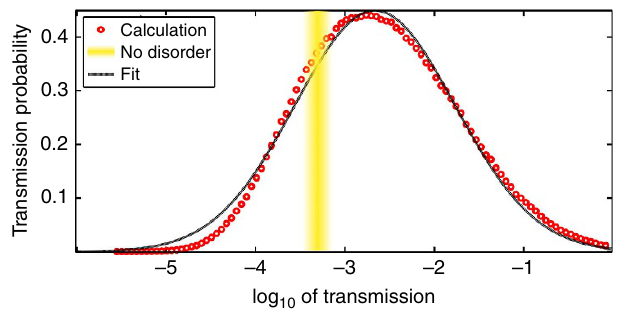
Figure 3 | Probability density of transmission in the EME regime. Transmission probability density for an N ¼ 180 structure (red circles), generated from an ensemble of 1 million realizations of the disorder. The distribution is compared against a Gaussian fit (black curve) and against the transmission of the disorder-free structure T C 10 (cid:3) 3.3 (yellow